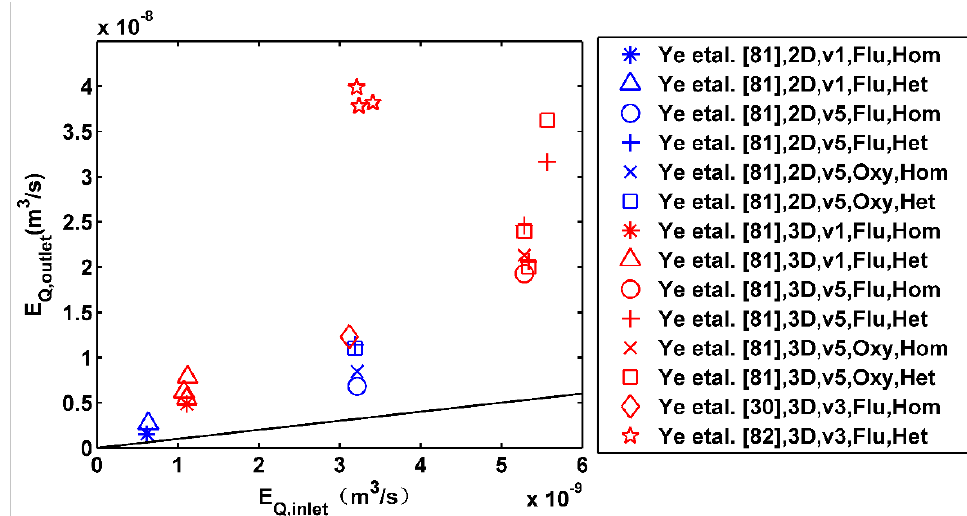
Figure 4. Flux-related dilution indices at the inlet and outlet for different experimental setups: the black line represents no dilution between outlet and inlet (i.e., E Q,outlet = E Q,inlet ); 2D and 3D indicate two-dimensional and three-dimensional flow-through systems respectively; v1, v3 and v5 represent flow velocities of 1 m/day, 3 m/day and 5 m/day respectively; Flu and Oxy represent a tracer solute of fluorescein and oxygen in conservative experiments respectively; Hom and Het represent homogenous and heterogeneous porous media.